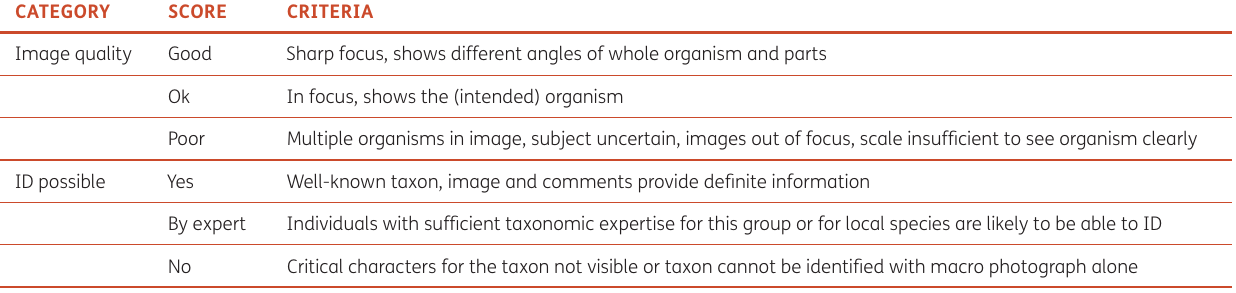
Table 1 Summary of the criteria to judge the quality of the collection of images for an observation and possibility of identification by an expert. The text contains additional information.